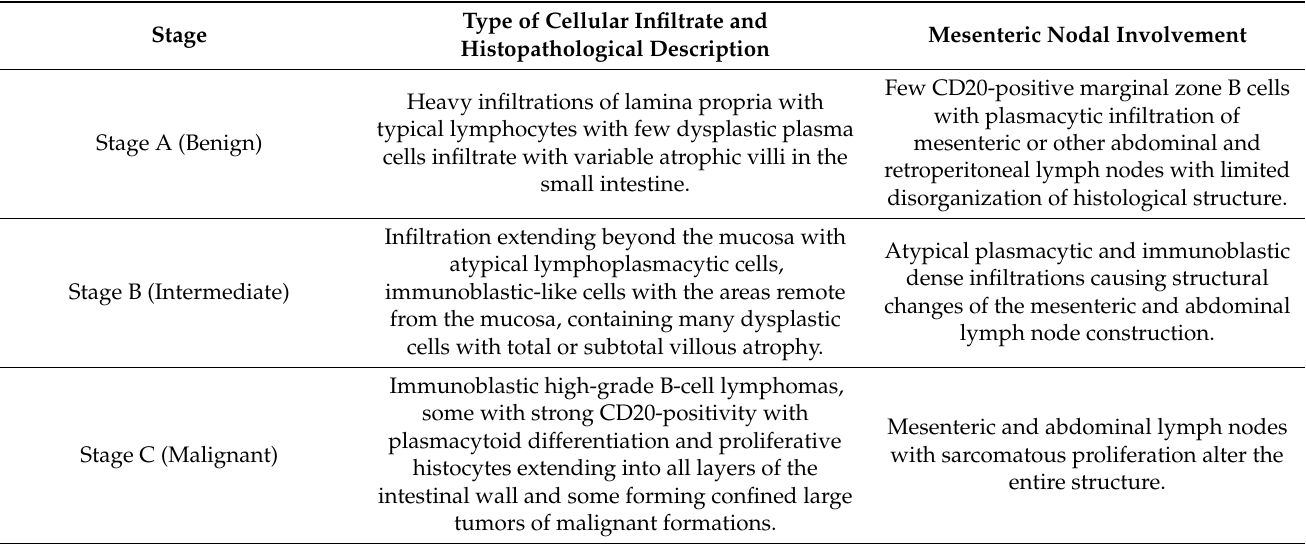
Table 3. Galian et al. histopathological staging of